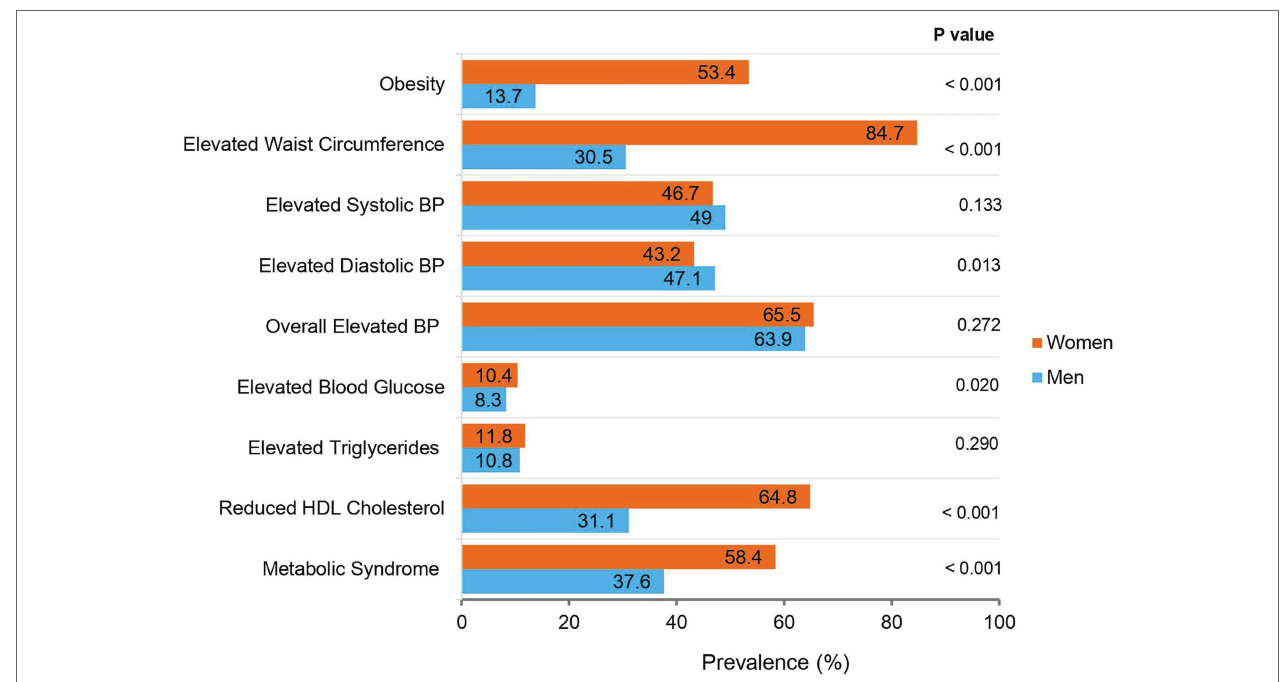
FIGURE 1 | The prevalence of obesity, the metabolic syndrome and its components in black South African men and women ( n = 4,431). p : Value of p for the statistical difference between men and women, using a chi-square test. BP, blood pressure. Obesity: Body mass index (BMI) ≥ 30 kg/m 2 ; Elevated Waist Circumference: ≥ 94 cm in men and ≥ 80 cm in women; Elevated Systolic BP: ≥ 130 mmHg; Elevated Diastolic BP: ≥ 85 mmHg; Overall Elevated BP: Elevated Systolic BP and/or Diastolic BP and/or using BP medication; Elevated Blood Glucose: Elevated fasting glucose ( ≥ 5.6 mmol/L) and/or using diabetes medication; Elevated Triglycerides: Elevated fasting triglycerides ( ≥ 1.7 mmol/L); Reduced high-density lipoprotein (HDL) Cholesterol: Reduced fasting HDL-cholesterol (<1.0 mmol/L in men, <1.3 mmol/L in women); Metabolic Syndrome: 2009 Harmonized Criteria (Alberti et al.,